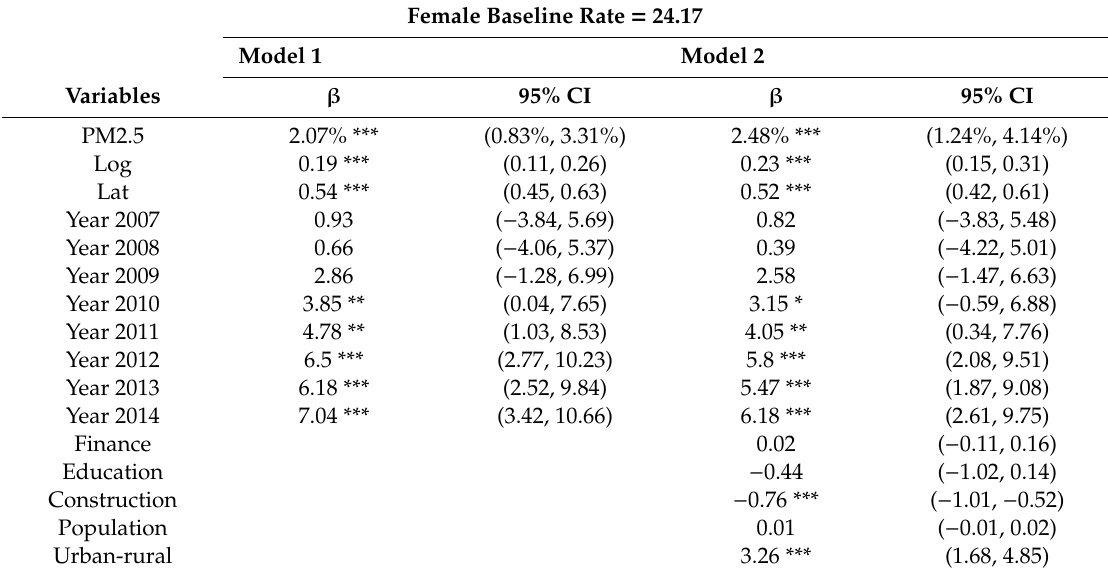
Table 3. Association between concurrent PM2.5 and the incidence rate of lung cancer for